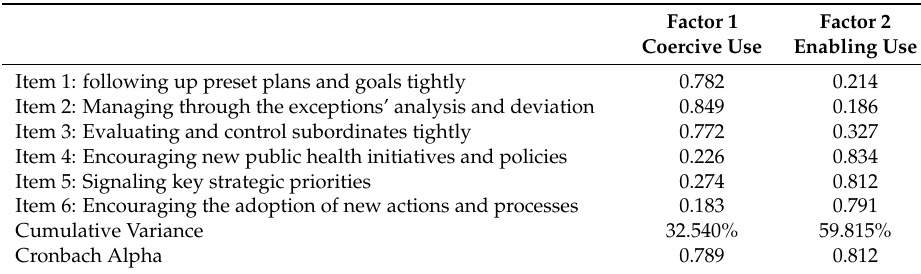
Table 1. Results of factor analysis for the uses of management control practices.